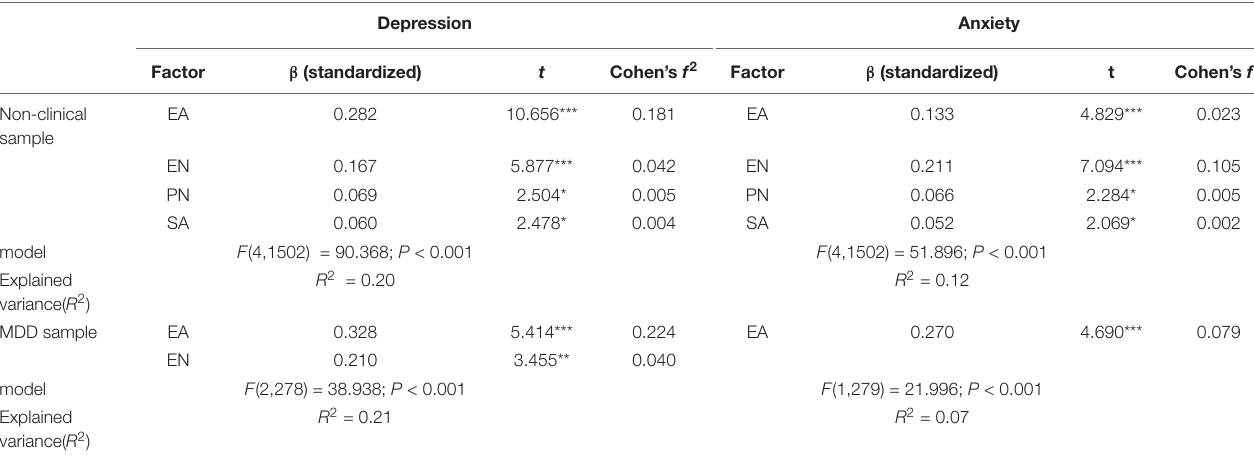
TABLE 8 | Multiple regression analysis on symptoms of depression and anxiety for non-clinical sample and MDD